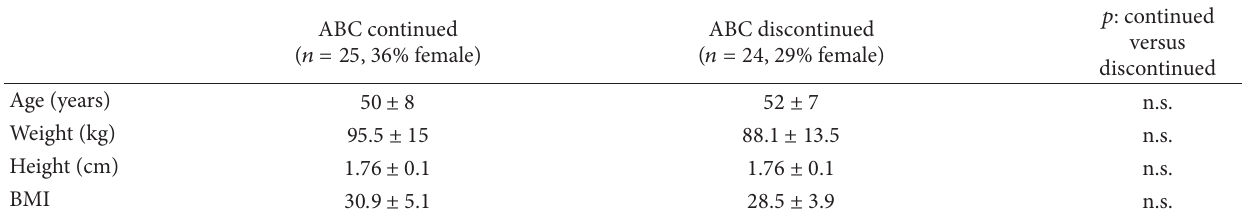
Table 1: Demography of participants who were followed up for a second year. The mean weight in the “ABC discontinued” group was somewhat lower than in the “ABC continued” group, but the difference did not reach statistical significance ( 𝑝 = 0.136 ). The figures given are means and standard